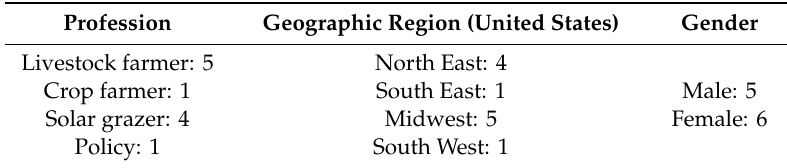
Table 1. Interview Participant